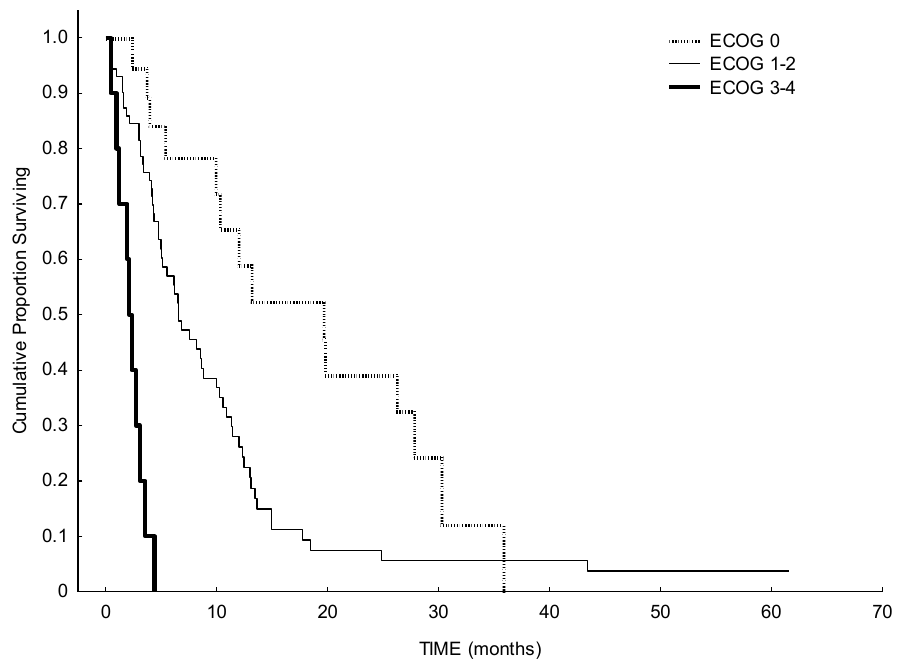
Figure 3. Survival analysis from starting of HMA according to ECOG performance status at relapse. Patients with ECOG 0 showed a median OS of 19.6 months, patients with ECOG 1–2 or 3–4, showed a median OS of 6.5 months and 2.1 months, respectively ( p < 0.0001). Median OS after HMA in patients with SD as best response to HMA was similar to median OS in patients who obtained a response to HMA (10.6 months vs. 13 months), while OS in unresponsive patients was 3.3 months ( p < 0.00001). On multivariate analysis, OS differences between: 1) secondary AML and de novo AML; 2) SD and responsive group vs. progressive disease group; and 3) patients with ECOG 0 and >1 remained significant. Hazard ratio for death for secondary AML vs. de novo AML was 1.84 (CI 95%, p = 0.018); for ECOG 1–2 patients vs. ECOG 0 patients it was 3.1; and for ECOG 0 vs. ECOG 3–4 it was 6.2, ( p < 0.001, CI 95%).